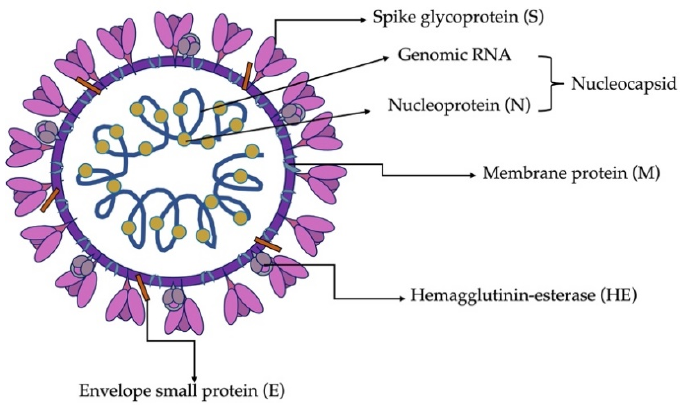
Figure 3. Schematic structure of SDAV virion. Own work based on [42-44].